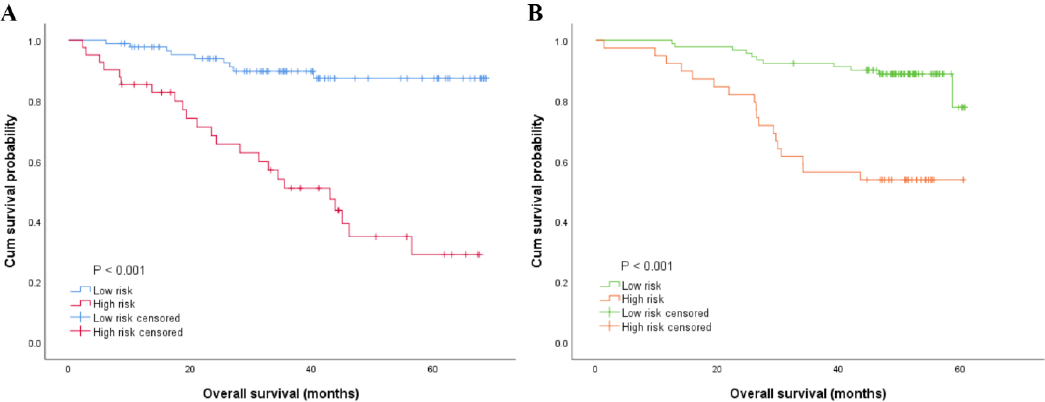
Figure 4. Kaplan–Meier curve was used to evaluate the prognosis based on the predictors from the nomogram model in the primary cohort ( A ) and those in the validation cohort ( B ).